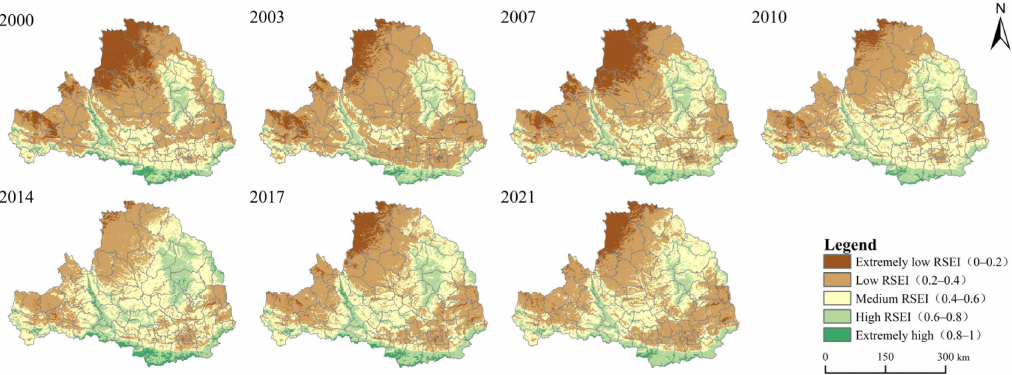
Figure 4. Spatial pattern of the eco-environment quality in the Weihe River Basin during 2000–2021.